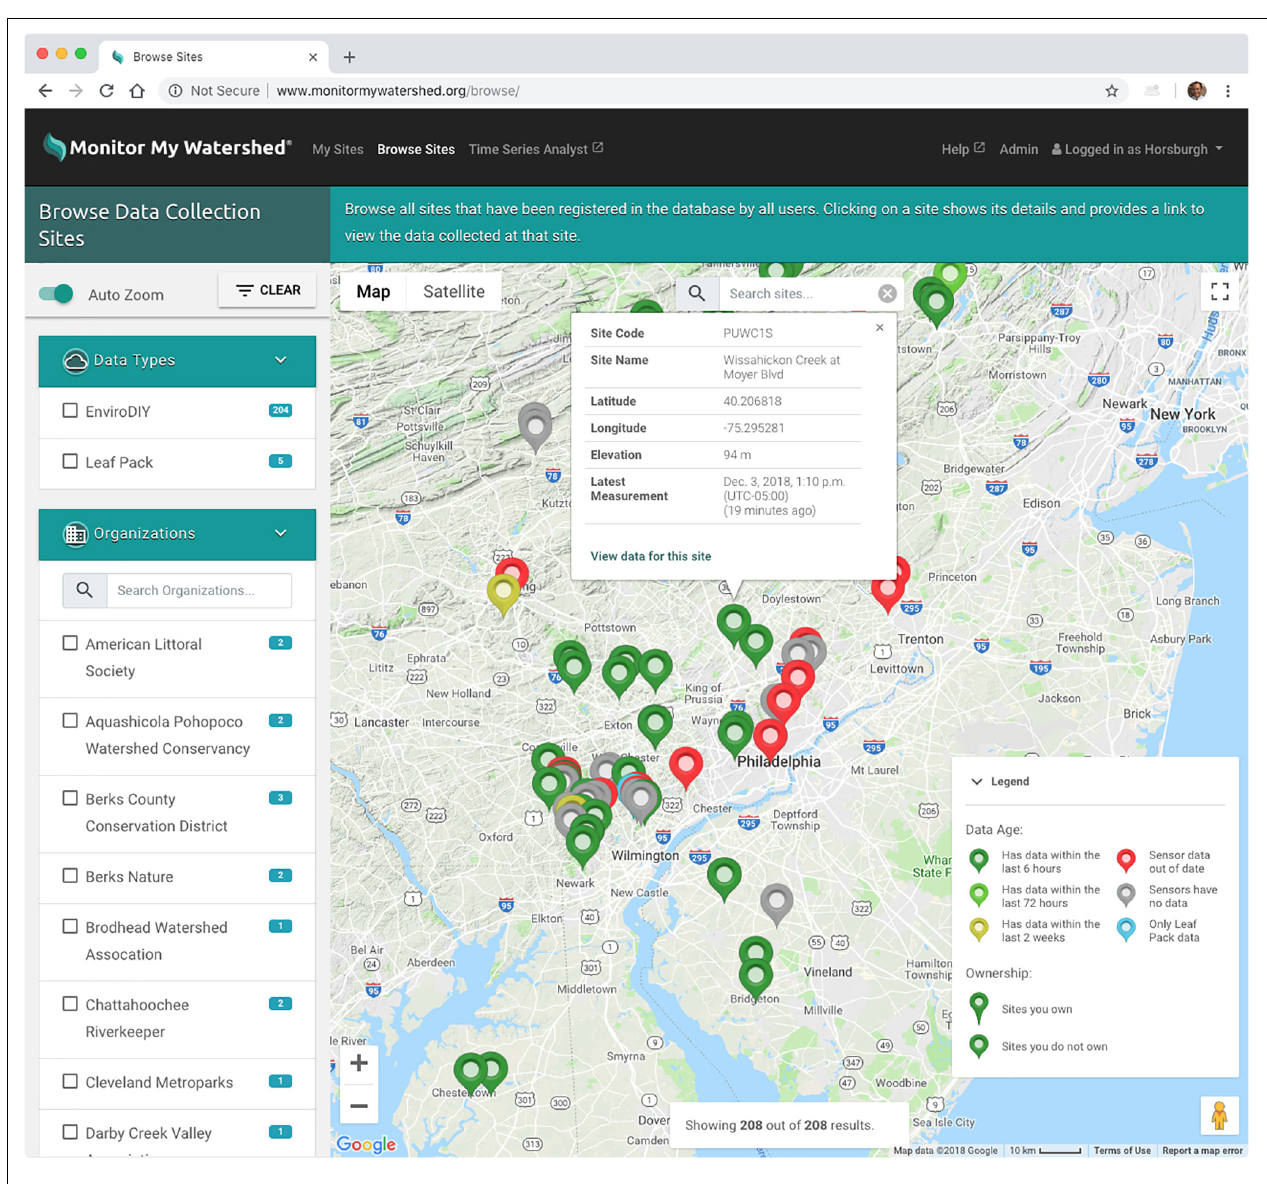
FIGURE 6 | Detailed view of the Browse Sites page of the Data Sharing